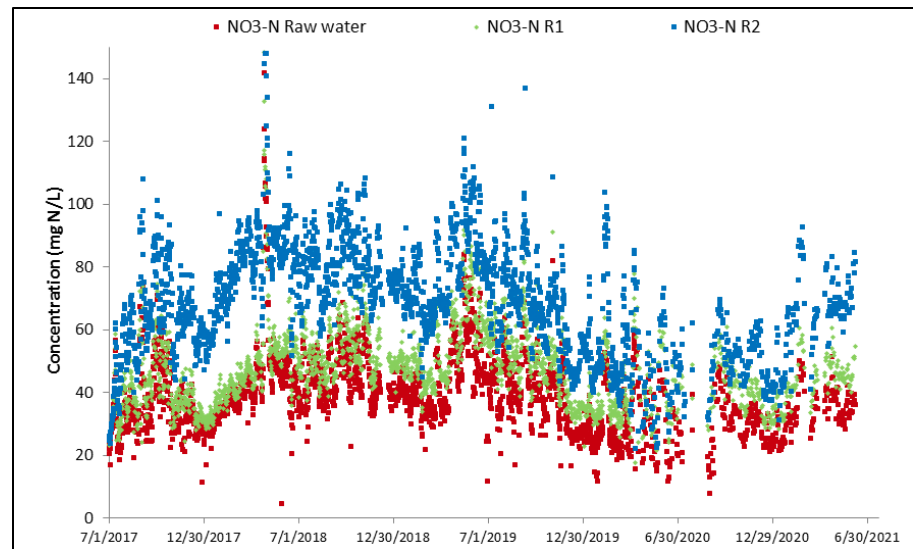
Figure 11. Evolution of NO 3 concentration across MBBR.